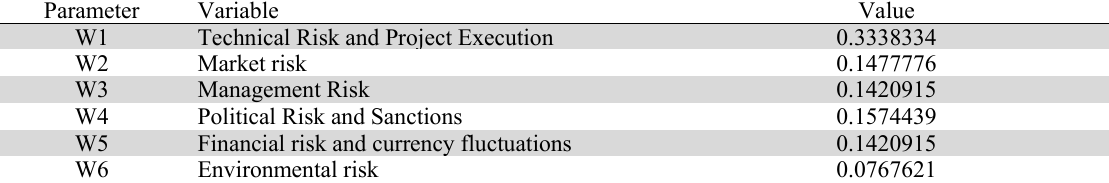
The summary of the results of ranking using